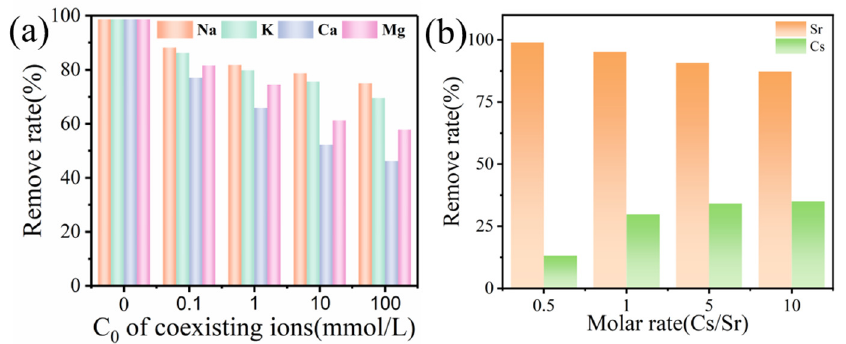
Figure 5. ( a ) Sr 2+ adsorption e ffi ciency at di ff erent concentrations of competing ions, ( b ) Sr 2+ adsorp- tion e ffi ciency at di ff erent Molar rate